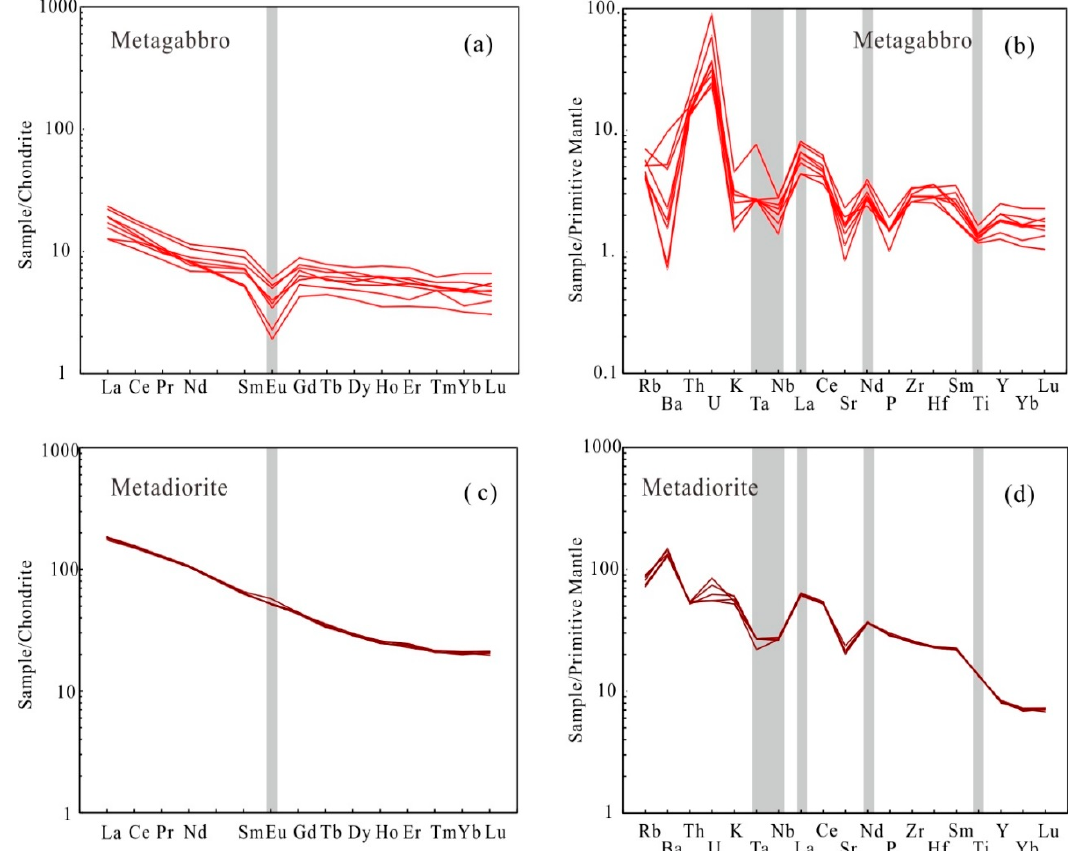
Figure 5. Chondrite-normalized REE patterns ( a , c ) and primitive mantle-normalized trace element patterns ( b , d ) of meta-mafic rocks (chondrite and primitive mantle values are from